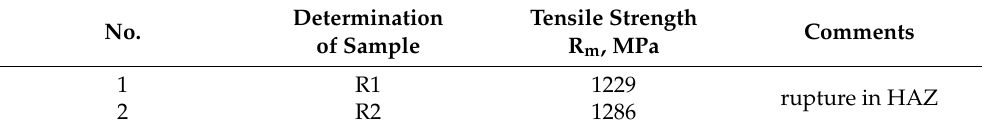
Table 5. Static tensile test results.